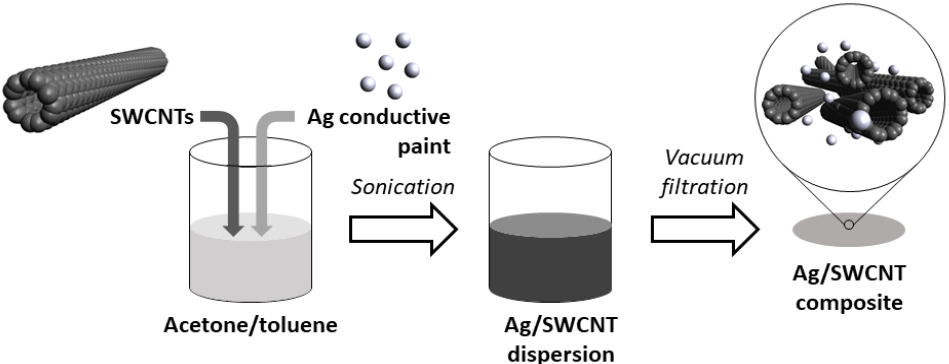
Figure 1. Manufacture of Ag-SWCNT (single-walled carbon nanotube) composites in the form of free-standing films by vacuum filtration. The microstructure of the material was modeled by Avogadro: an open-source molecular builder and visualization tool [45].